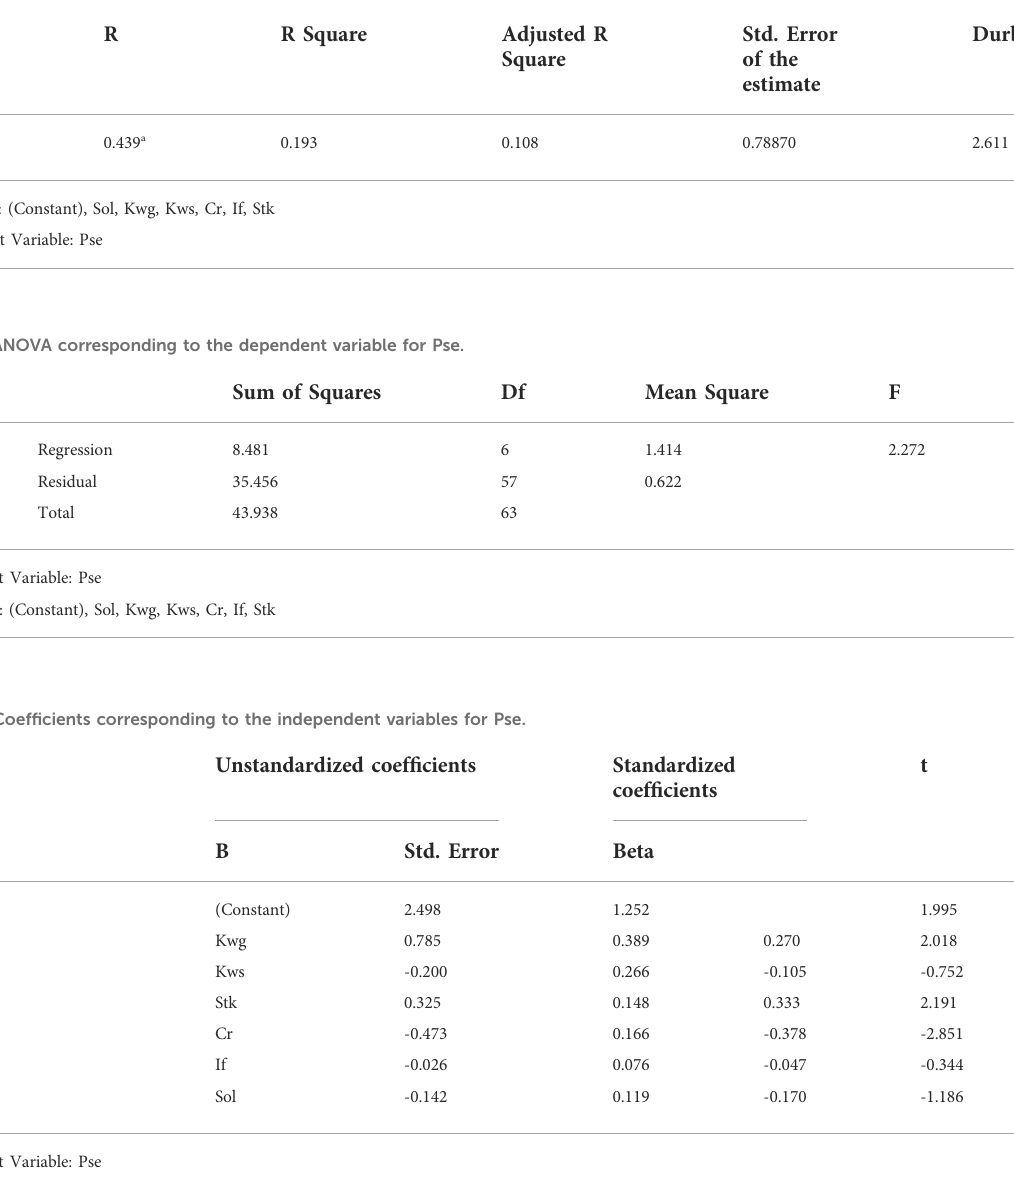
TABLE 16 Summary model corresponding to the dependent variable for Pse.